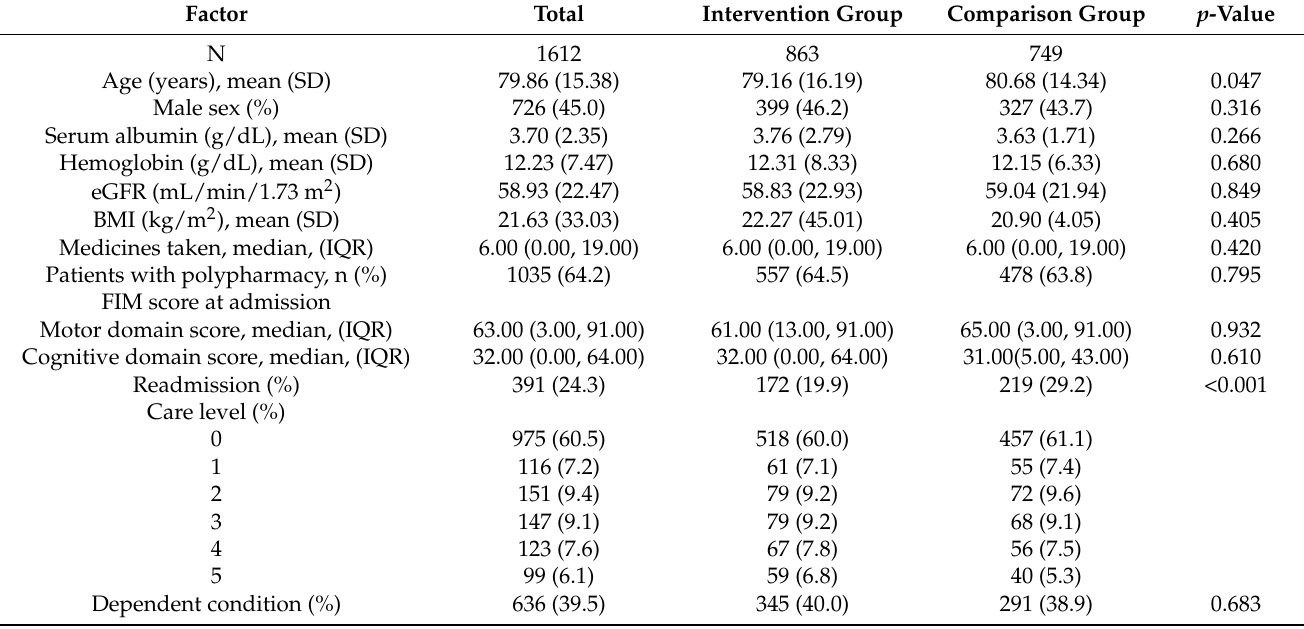
Table 2. Demographics of the